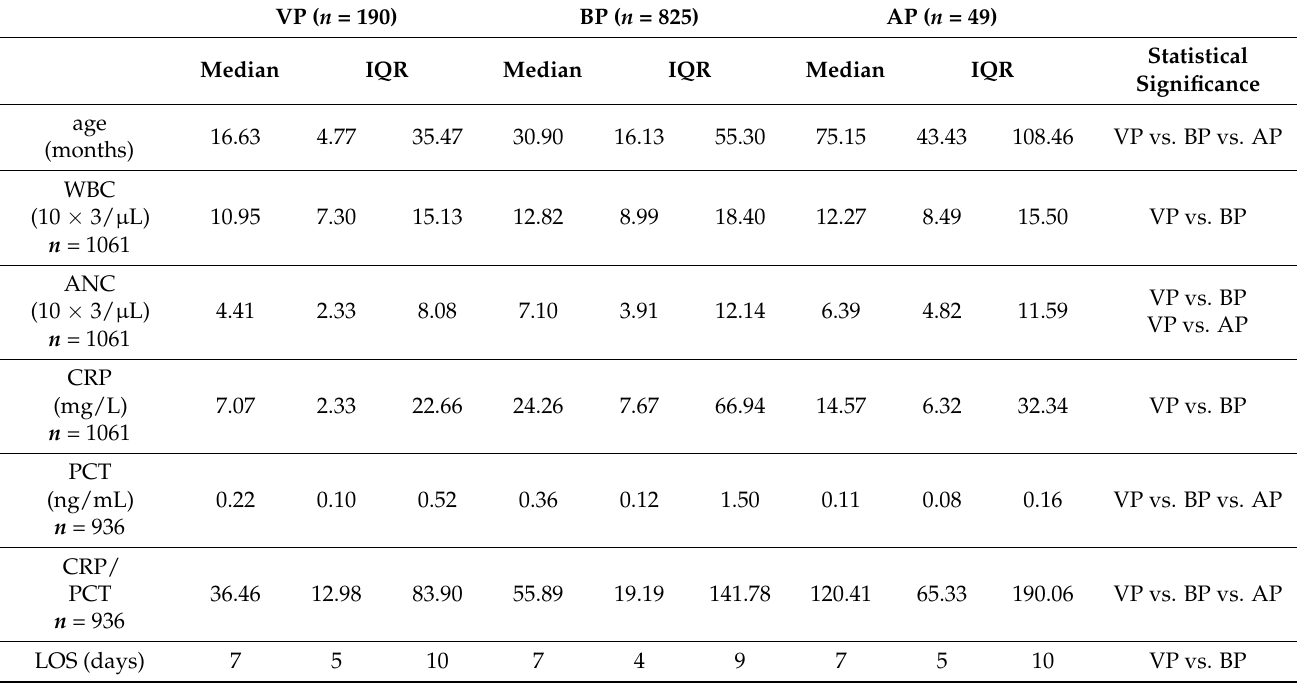
Table 2. Baseline characteristics of the study group. Non-parametric Kruskal–Wallis with correspond- ing post hoc test (multiple range comparison) was used to verify statistically significant differences (shown in the right